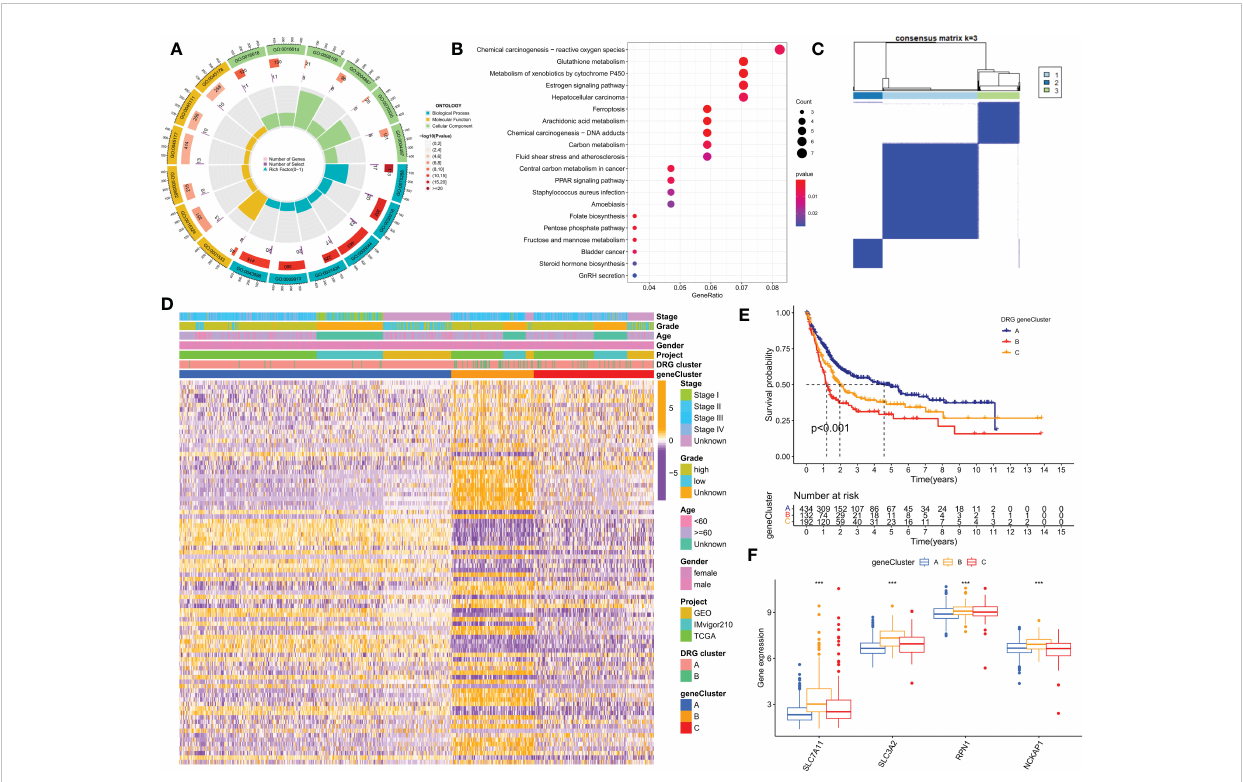
FIGURE 4 Identi fi cation of DRG gene clusters based on differentially expressed genes (DEGs) in DRG clusters. (A, B) GO and KEGG enrichment analysis of DEGs in two DRG gene clusters. (C) The consensus clustering algorithm (k = 2) was used to divide all samples in TCGA-BLCA, iMvigor210, and GSE13507 cohorts into 3 DRG gene clusters. (D) Heatmap of clinical pathological features and expression of DEGs. (E) Kaplan-Meier survival analysis of different gene clusters. (F) Differences in the expression of four DRGs among different gene clusters. GO, Gene Ontology; KEGG, Kyoto Encyclopedia of Genes and Genomes. ***P<